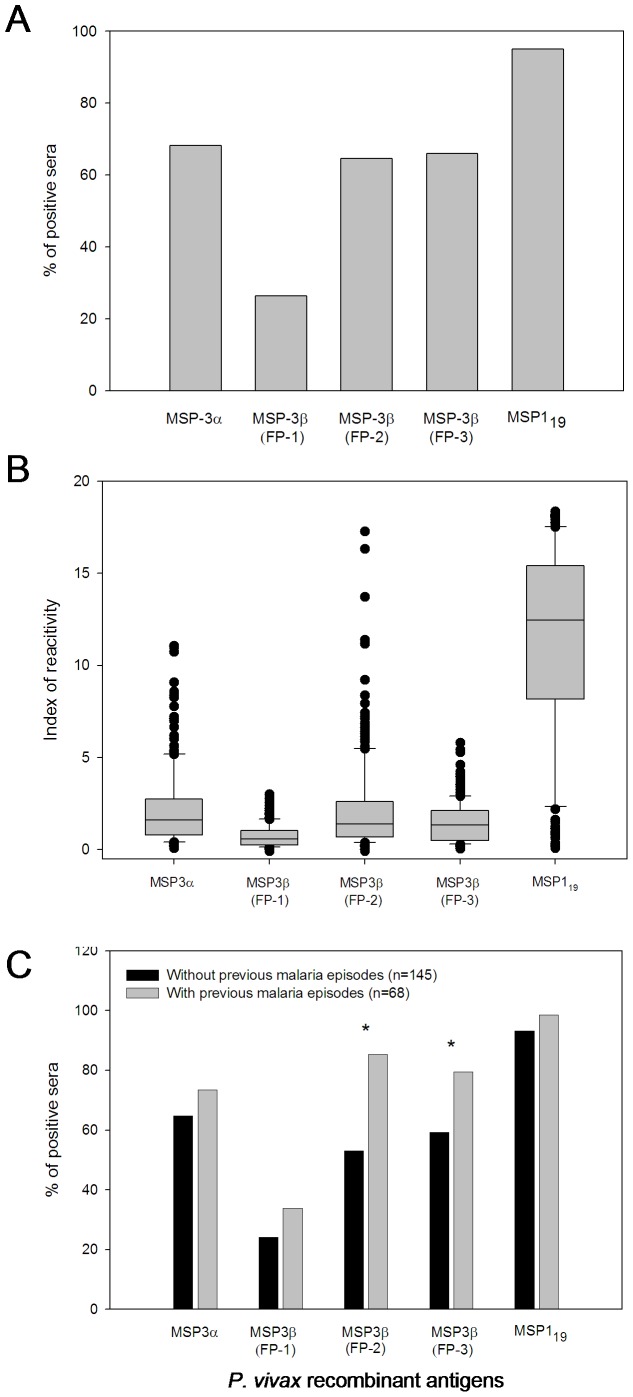
Human antibody response to recombinant PvMSP-3α, PvMSP-3β, and PvMSP119 proteins during patent P. vivax infection.
A) The bars express the percent response for each of the analyzed proteins. Sera from 220 individuals were analyzed for the presence of specific IgG antibodies by ELISA and tested at a 1∶100 dilution in duplicate. The cutoff proteins obtained from the PvMSP-3α, PvMSP-3β (FP-1), PvMSP-3β (FP-2), PvMSP-3β (FP-3), and PvMSP119 were 0.179, 0.715, 0.195, 0.396, and 0.185, respectively. B) Comparison of individual IR IgG antibodies to MSPs in sera of individuals infected by P. vivax. The line indicates the limit of positivity (IR = 1). IR: Index of reactivity (mean absorbance of test serum/cutoff). C) Comparative analysis of the IgG antibody response against MSP proteins and the frequency of previous episodes of vivax malaria. We analyzed 213 serum samples from individuals who reported the number of previous episodes of malaria for the presence of specific IgG antibodies by ELISA. All sera were tested in duplicate at 1∶100 dilution. *: the percentage of responders with statistically significant correlation to the frequency of previous malaria episodes.